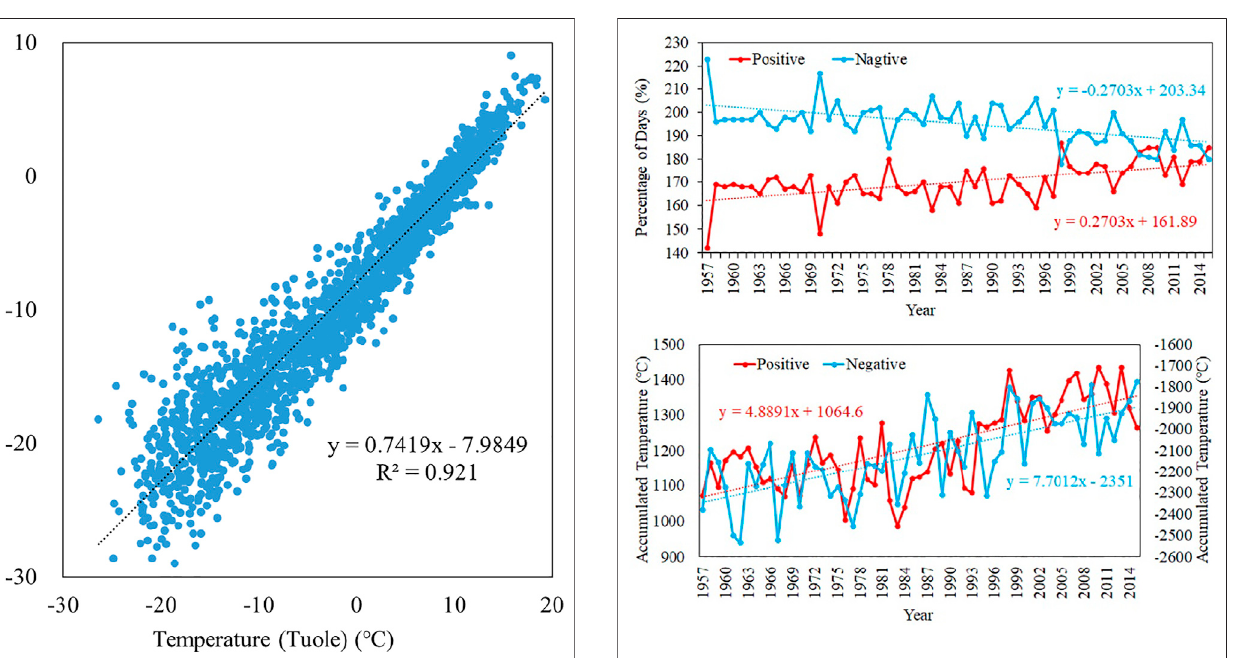
FIGURE 5 | Relationship of temperature between Tuole and LHG12, 2010 – 2015.